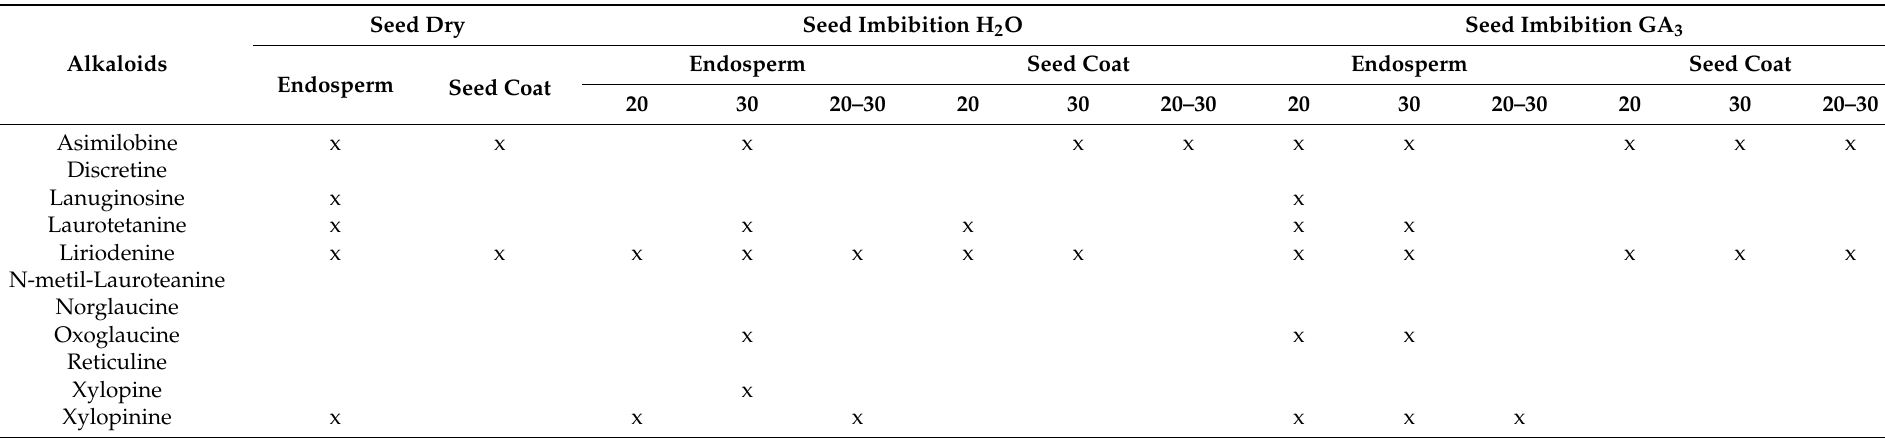
Table 3. Presence (x) or absence ( ) of alkaloids in the seed structures (seed coat and endosperm) of Annona x atemoya Mabb. cv. ‘Gefner’ seeds immersed for 36 h (solution with H 2 O or GA 3 ) at different temperatures (20 ◦ C, 30 ◦ C, and 20–30 ◦ C) and dry